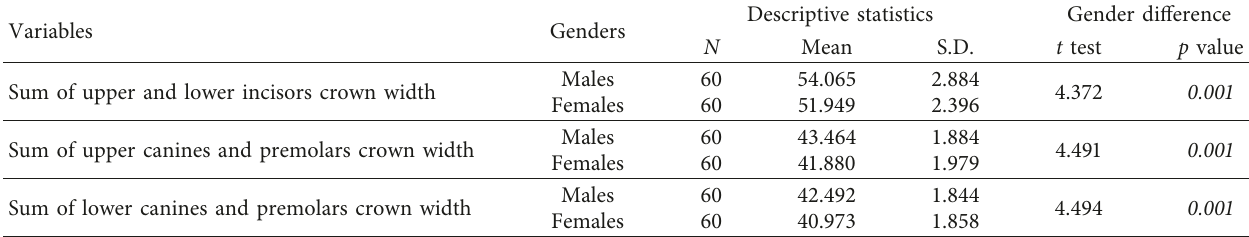
Table 1: Descriptive statistics and gender difference for the variables measured.